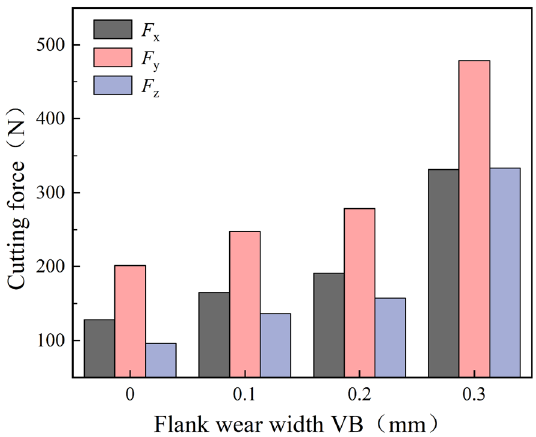
Figure 10. Experimental results for cu tt ing force.